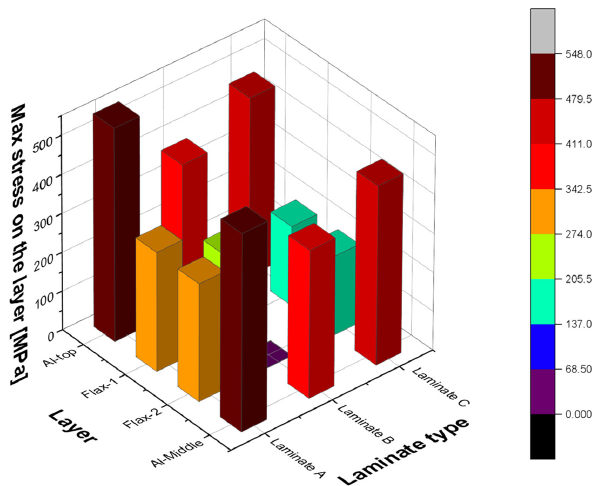
Figure 17. Maximum stress comparison between all three laminate types for the first four layers of each laminate . each